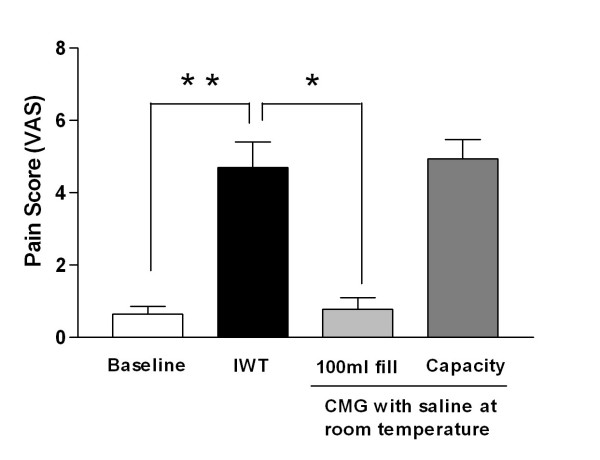
Pain scores in PBS patients at baseline, IWT and CMG. Bar chart showing the Pain Scores (VAS) at baseline, during the Ice Water test (IWT), filling to 100 ml with saline at room temperature, and filling to bladder capacity during routine urodynamics, in PBS patients (n = 17). Significantly higher pain scores were observed during ice water instillation compared to the baseline (P = 0.0002**) or equivalent amount of bladder filling (100 mls) with saline at room temperature (P = 0.015*), and were similar to pain scores on filling to bladder capacity.